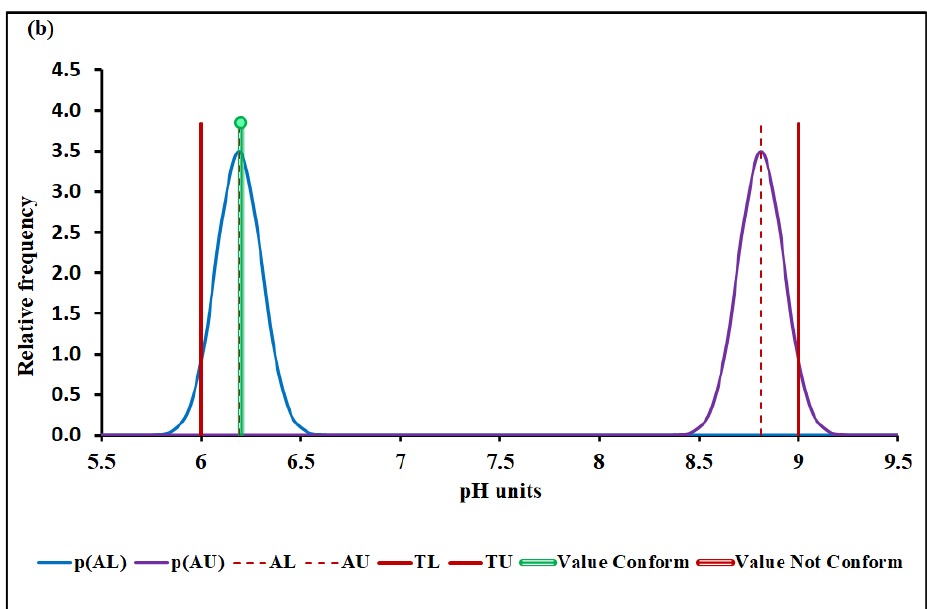
Figure 3. pH conformity assessment based on ( a ) MADe approach and ( b ) nIQR approach. p(AL) − probability density at the lower acceptance limit; p(AU) − probability density at the upper ac-ceptance limit; AL − lower acceptance limit; AU − upper acceptance limit; TL − lower tolerance limit; TU − upper tolerance limit.